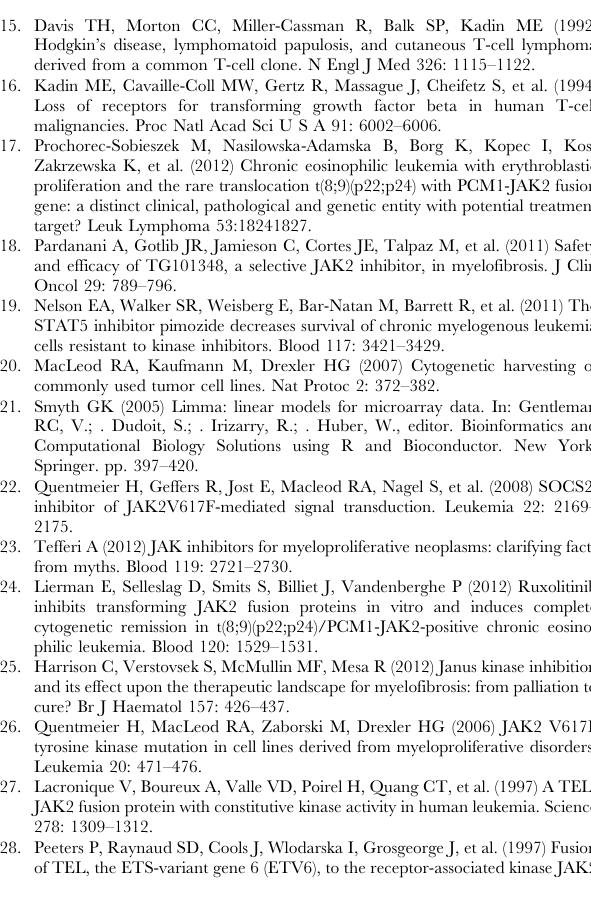
Figure S1 Amino acid sequences at breakpoints in PCM1 and JAK2. Gives amino acid sequences of PCM1 and JAK2, those retained in the fusion product are shown in black. Figure S2 Transcription factor binding sites of STAT3 and STAT5. The figure is drawn from the UCSC browser (HG19) and covers SOCS2 and SOCS3 . Note presence of TFBS for STAT3 and STAT5 at both SOCS loci. Figure S3 Differential expression of GATA3 regulators in MAC-1/2A/2B cells. Microarray heatmap (left) shows expression of known GATA3 regulators (arrows showing whether positive/ negative). NOTCH2 (positive) and TGF b 1 (negative) regulators like GATA3 are differentially regulated in MAC-1 and MAC-2A/B cells. However, normalized GATA3 expression (RQ-PCR) after 72h treatment with neither DAPT ( c -secretase inhibitor) nor TGF b 1 evidence modulation (right). Vehicle control data (black) shown left of treatment. Table S1 Ontology profiling of genes upregulated in MAC-1/ 2A/2B versus control T-ALL (A) or CTCL (B) cell lines listed in the Materials and Methods. Shows ontology profiling using the